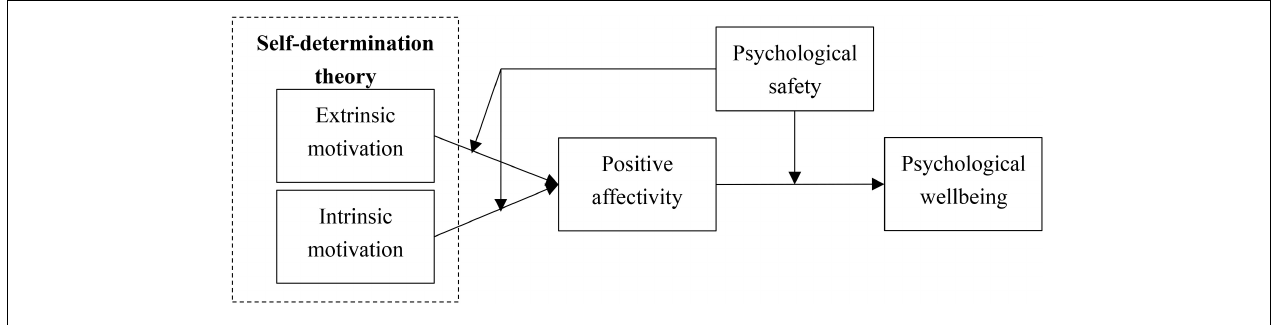
FIGURE 1 | Research